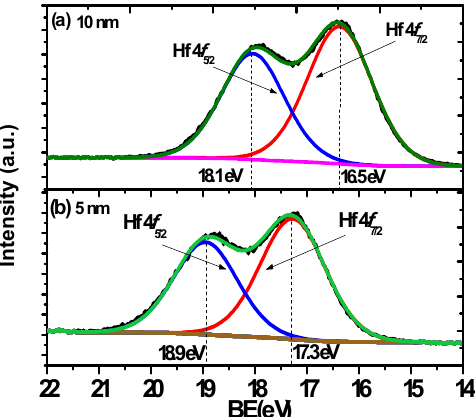
Figure 1. The XPS line shape for HfO 2 thin films with the thickness of ( a ) 10 nm and ( b ) 5 nm. The sample with a thickness of 10 nm has the lower bonded peak at the position of 16.5 eV for Hf 4 f 7/2 spectra. For the sample with a thickness of 5 nm, the bonded peak for Hf 4 f 7/2 spectra is centered at 17.3 eV, with a difference of 0.8 eV in comparison to 10 nm one. This shift is probably due to the reaction of HfO 2 with the germanium for the 5 nm HfO 2 sample.